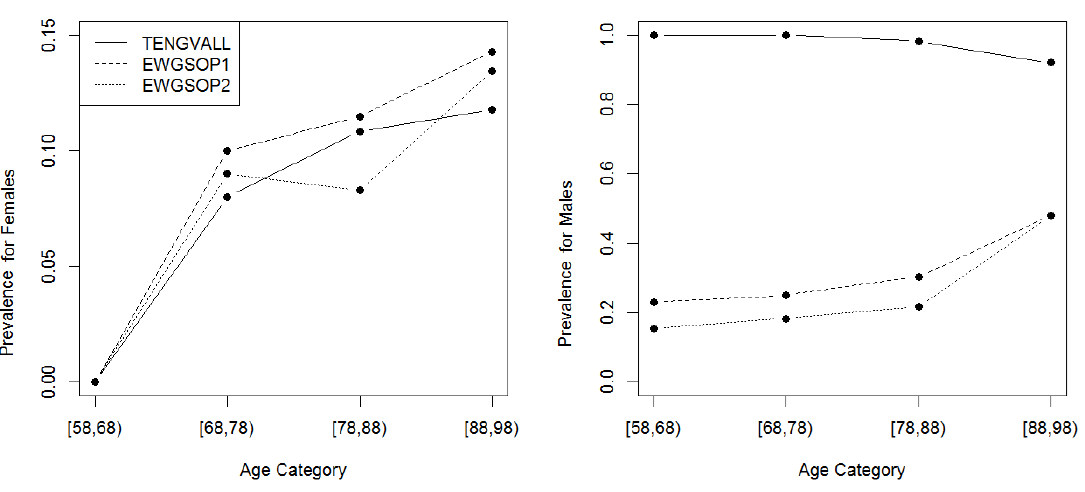
Figure 1. The prevalence of low appendicular skeletal muscle mass index (ASMI) under each diagnostic criterion and calculated over age categories for females and males, separately. The abbreviation used is: European working group on sarcopenia in older people 1 (EWGSOP1) and 2.